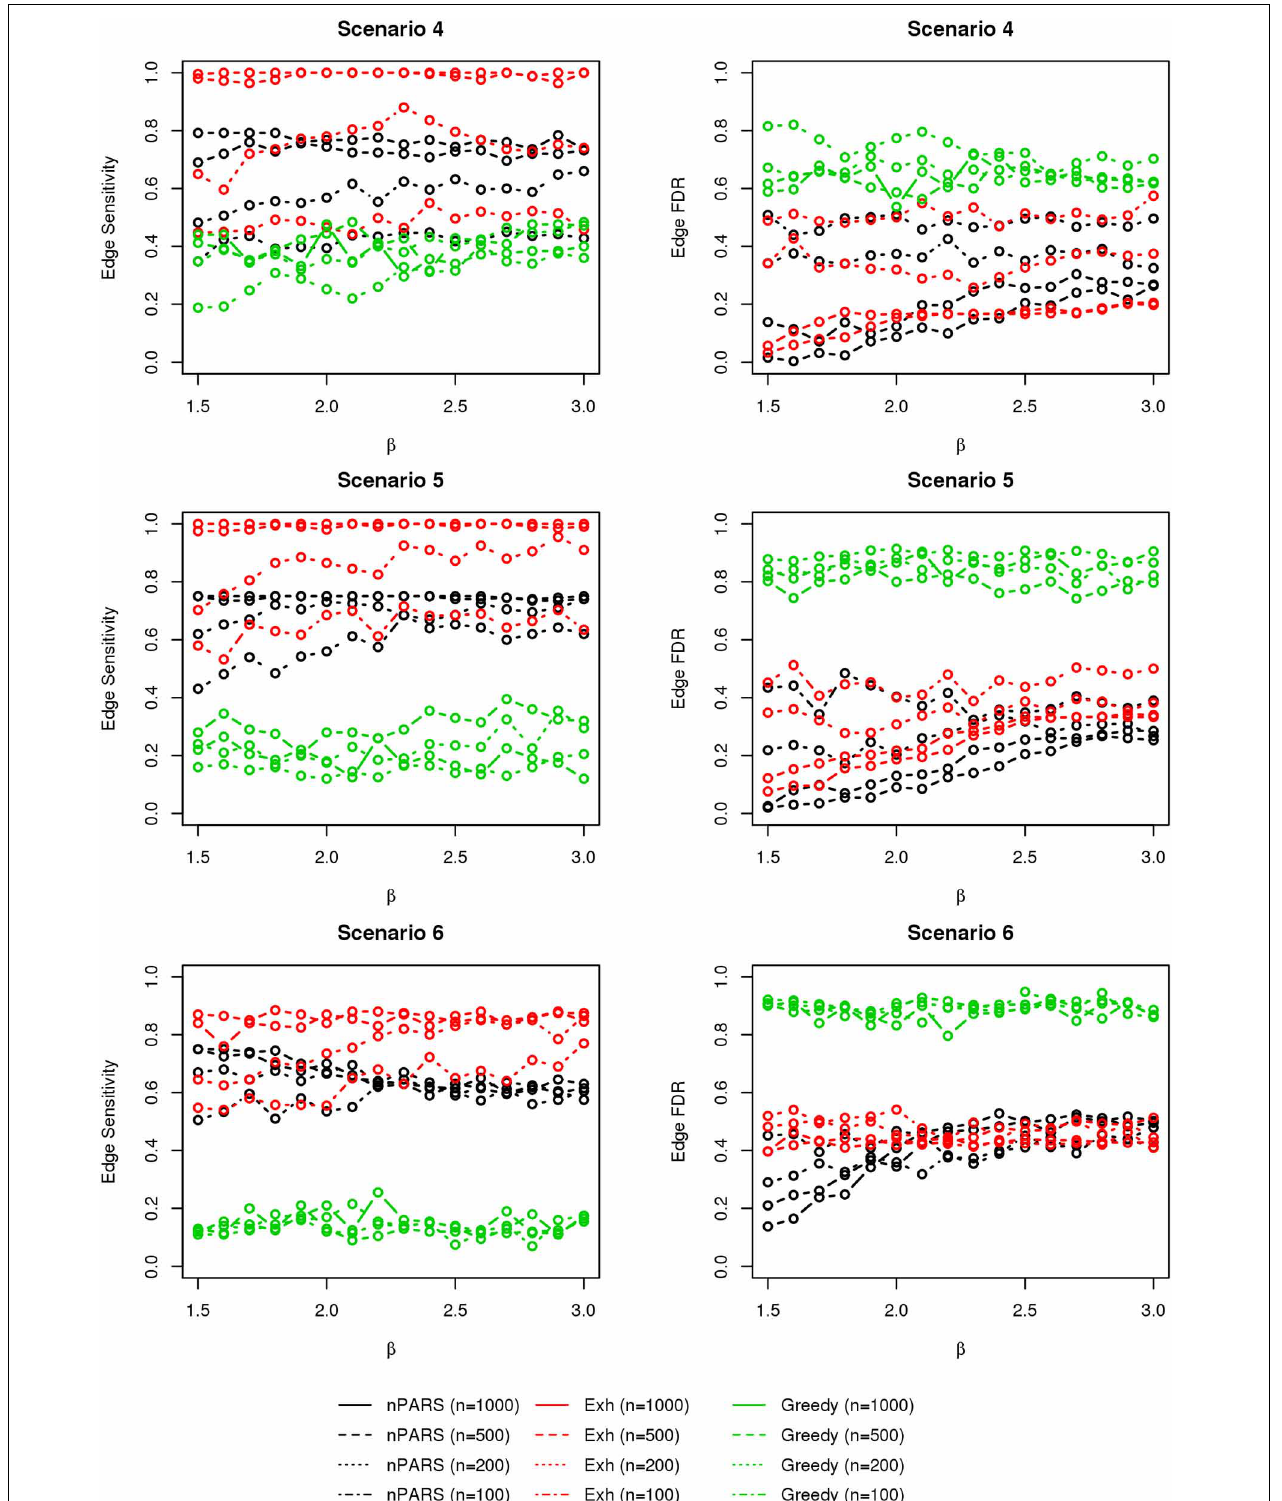
FIGURE 8 | The sensitivity and FDR of edge comparisons in simulation scenario 4–6. The same legend is used as in Figure 6 . nPARS has higher edge sensitivity and lower edge FDR compare to GreedyE in scenario 4–6.